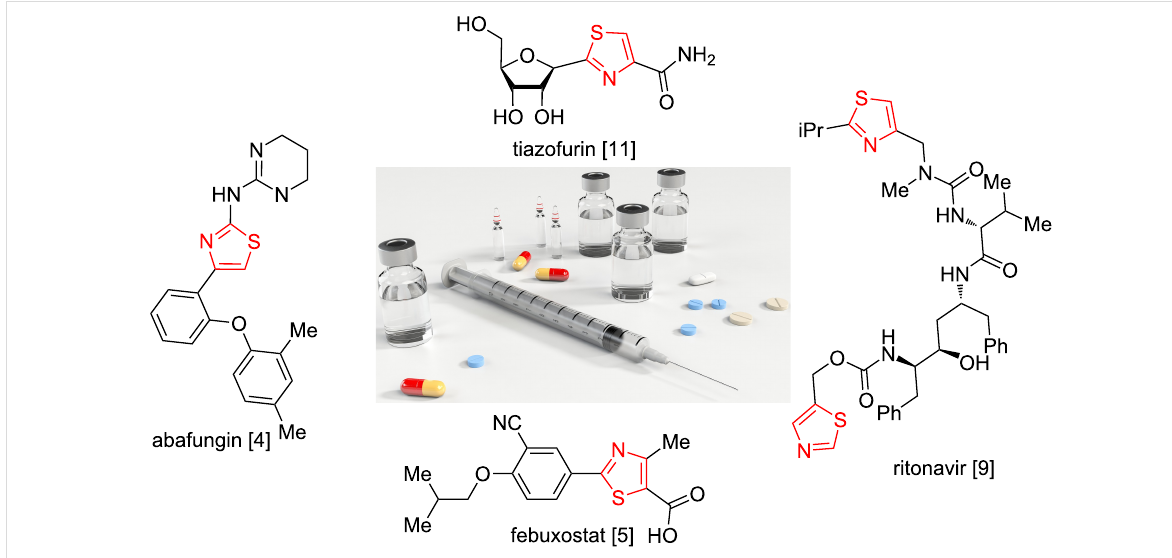
Figure 1: Selected examples of bioactive thiazole derivatives.